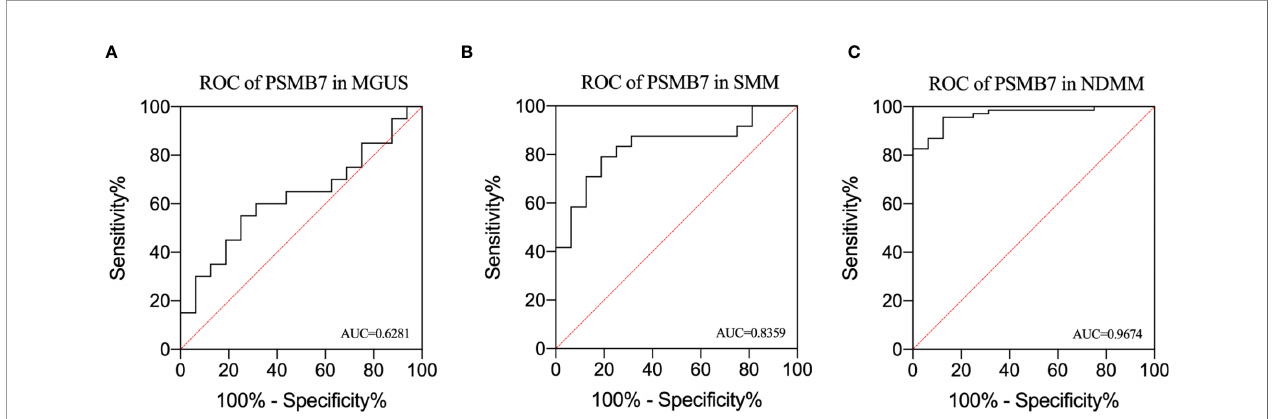
FIGURE 6 | Receiver operating characteristic curve analysis in MGUS, SMM, and NDMM. (A) ROC of PSMB7 in MGUS, (B) ROC of PSMB7 in SMM, (C) ROC of PSMB7 in